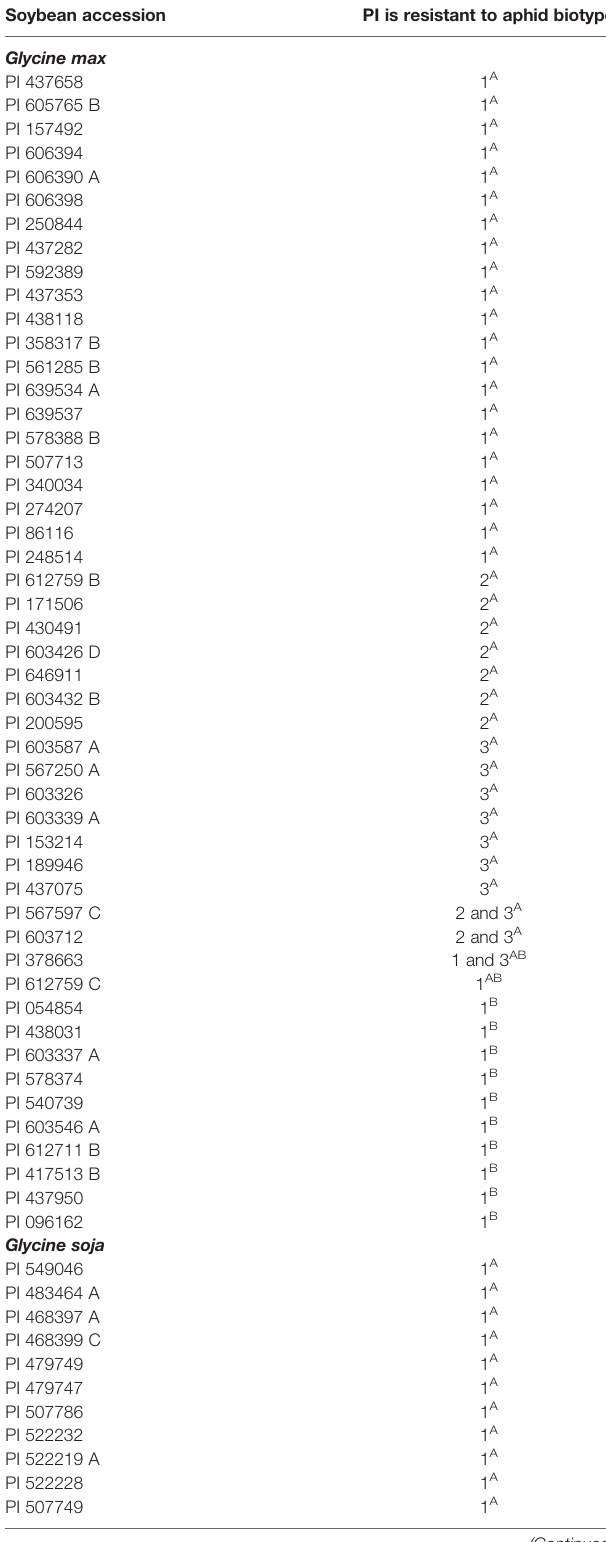
TABLE 1 | Aphid-resistant soybean genotypes (N=69) tested in genome-wide association studies (GWAS). Soybean accession PI is resistant to aphid